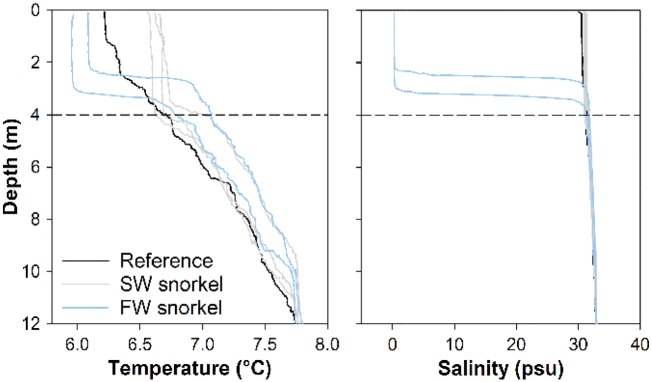
Temperature (left) and salinity profiles (right) in SW (grey) and FW snorkel cages (blue), and at a reference location indicative of conditions in standard cages (black line) on 24 January 2017. The snorkel depth (dotted horizontal line) at 4 m is displayed.